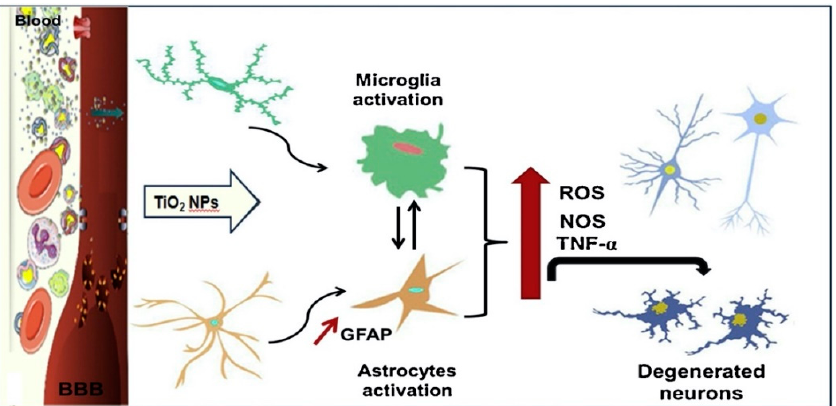
Figure 6. Mechanism of neurotoxicity of TiO 2 NPs in cells. Adapted with permission from [89].